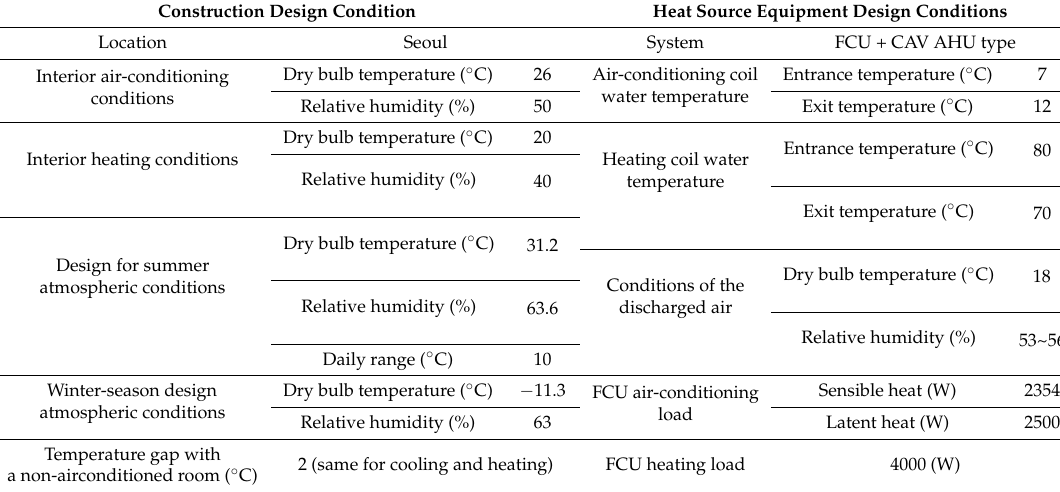
Figure 3. Zoning of the target office reference floor (Unit: mm). Table 4. Detailed design conditions for construction and heat source equipment.